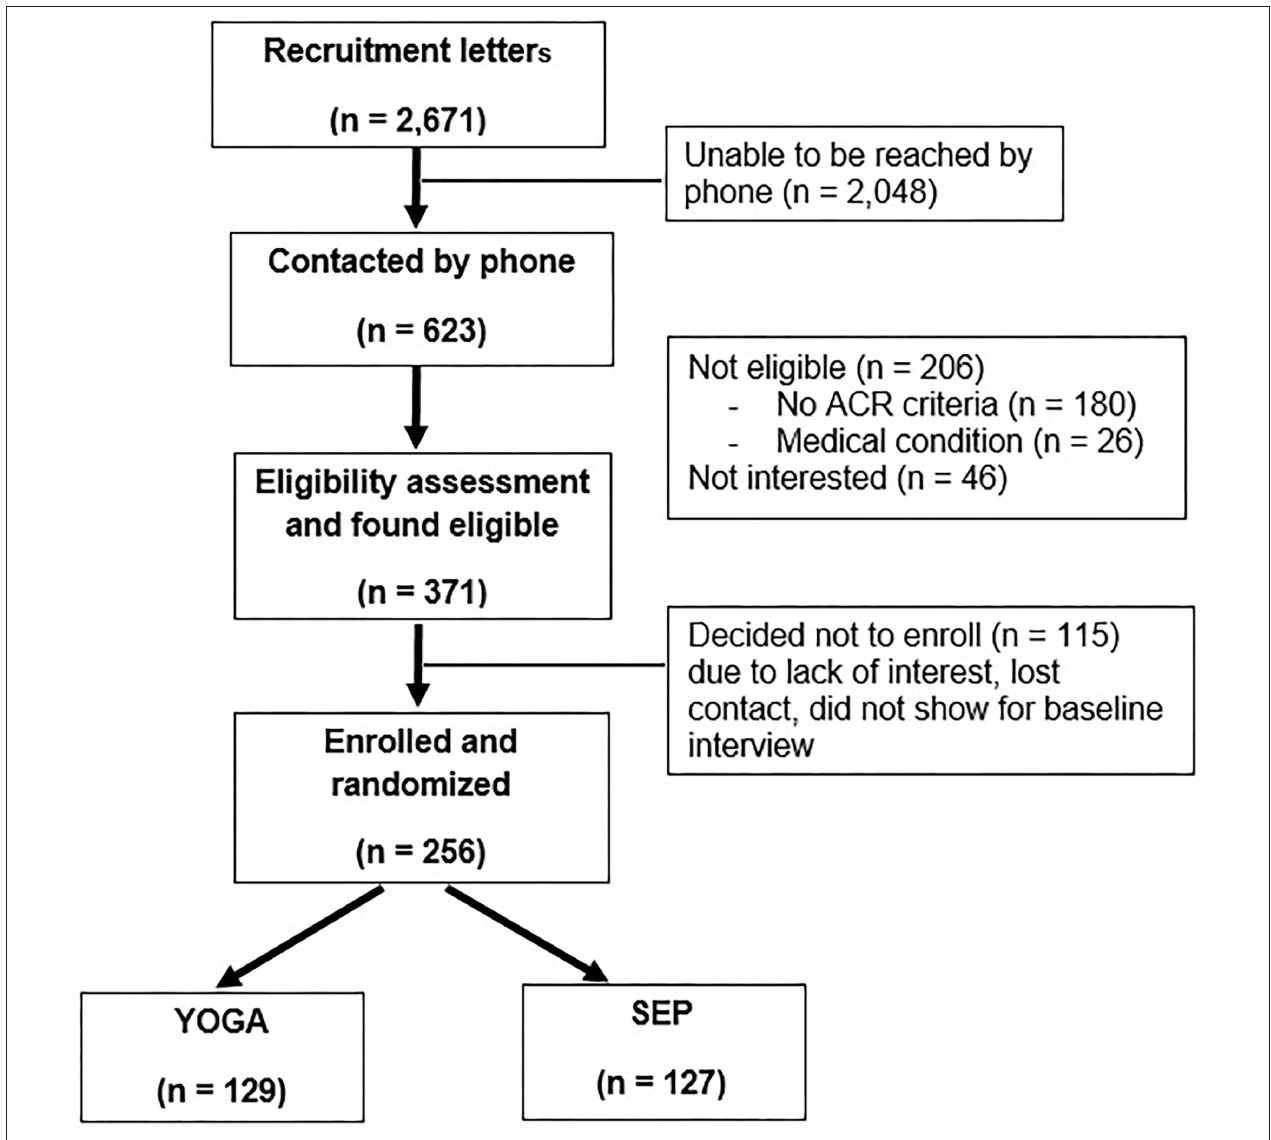
FIGURE 2 | Recruitment